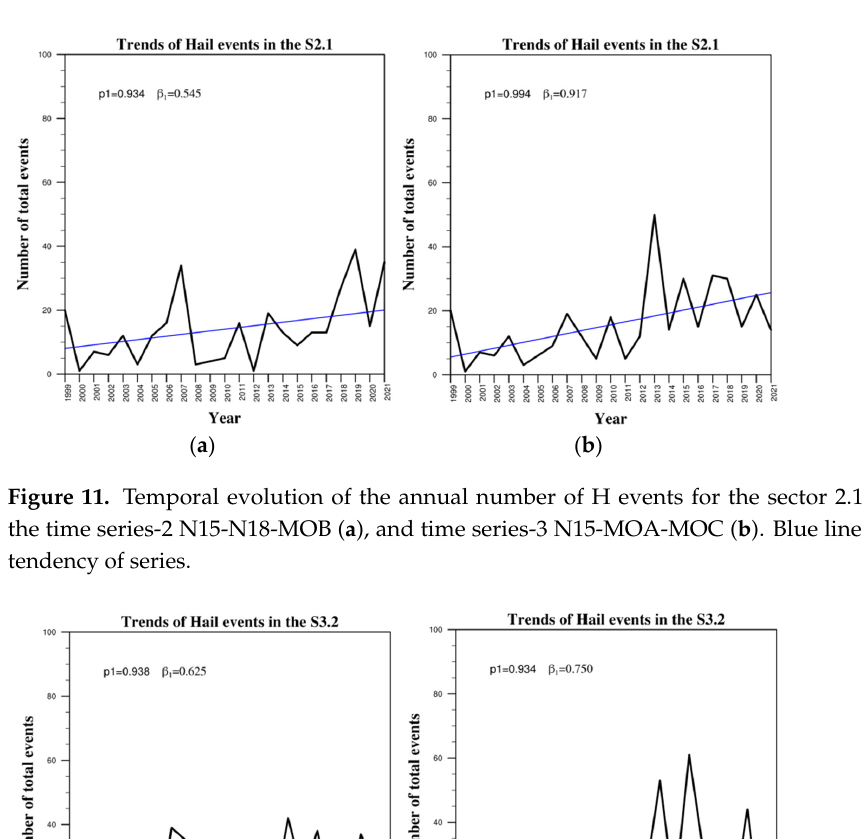
( c ) Figure 10. Temporal evolution of the annual number of H events for the sector 3.1 considering the three-time series in Table 2, i.e., time series-1 N15-N18-NPP ( a ), time series-2 N15-N18-MOB ( b ), and time series-3 N15-MOA-MOC ( c ).